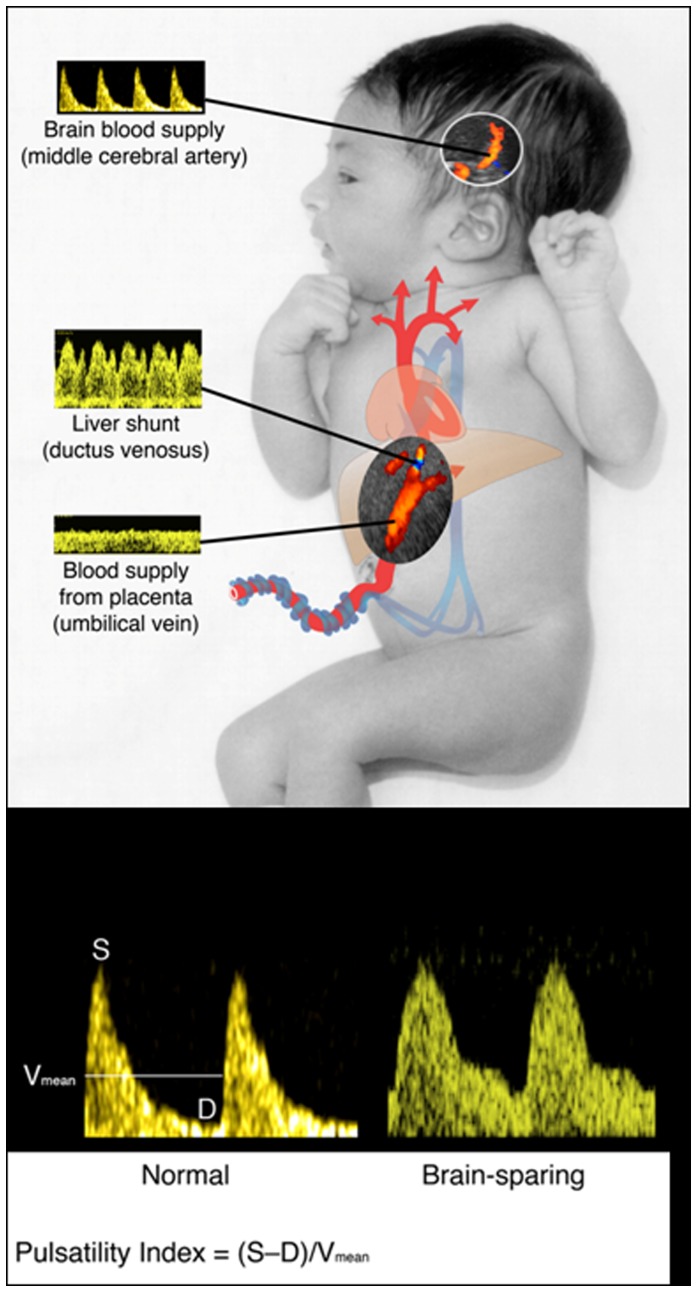
Diagrammatic representation of the fetal circulation, showing blood flow to the fetal liver and brain.(A) Nutrient-rich blood returning from the placenta in the umbilical vein either perfuses the fetal liver or bypasses it through the shunt of the ductus venosus. (B) “Brain-sparing” is associated with cerebral vasodilation, altering the blood flow velocity waveform in the middle cerebral artery, and lowering the pulsatility index. The figure is modified from Ref 20; reproduced with permission.